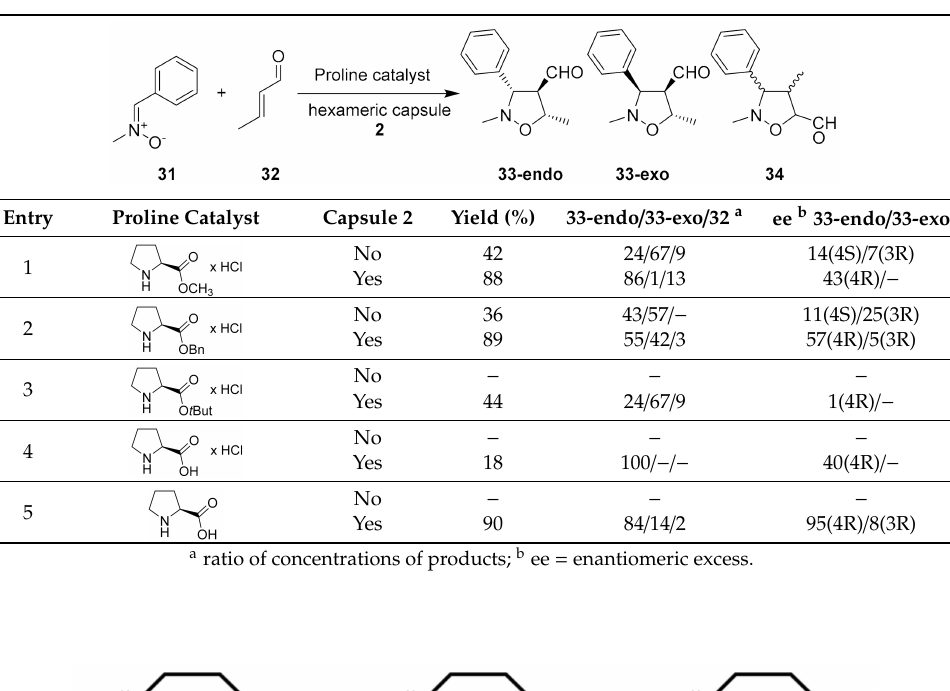
Table 7. Catalytic tests of cycloaddition between 31 and 32